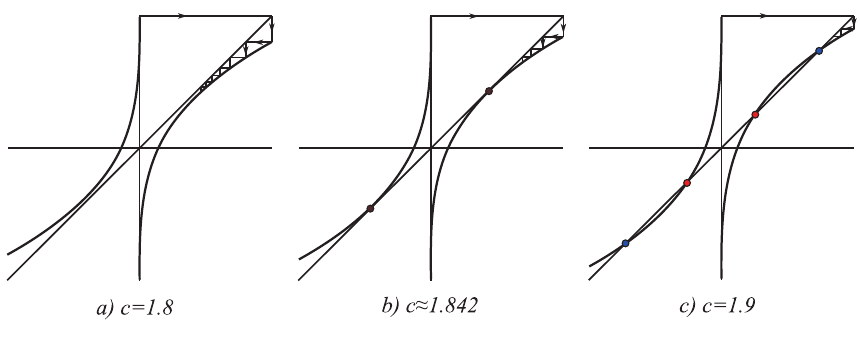
Fig. 8 Saddle-node bifurcation for ε = 0 . 7